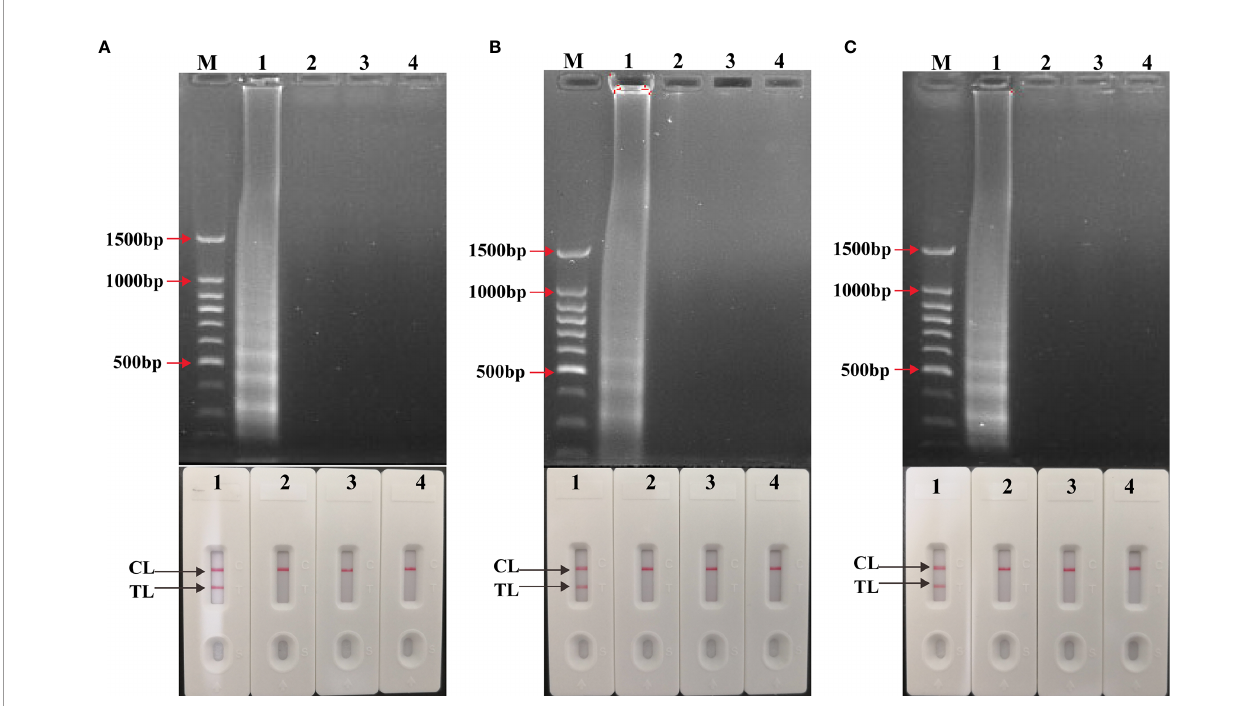
FIGURE 2 | Con fi rmation and detection of singlex LAMP and multiplex LAMP products. (A) Con fi rmation and detection the amplicons of IS 6110 -LAMP and (B) IS 1081 -LAMP and (C) multiplex LAMP. Top: 1.5% agarose gel electrophoresis using for ampli fi cation products analysis. Bottom: LFB applied for visual detection of amplicons analysis. Biosensors/lanes 1-4: positive products of H37Rv, Streptococcus pneumoniae and Escherichia coli as negative control, DW as blank